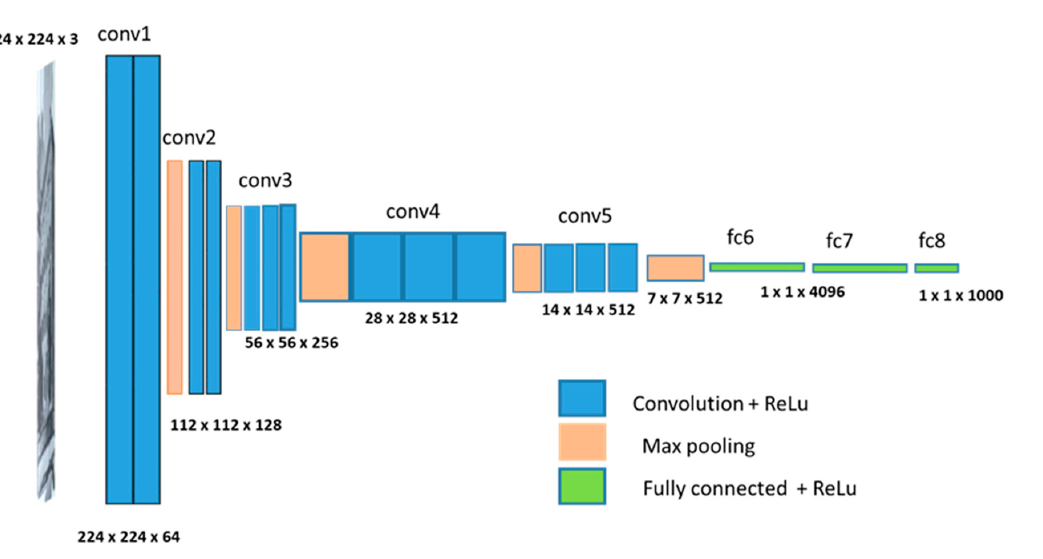
Figure 3. VGG 16 architecture.